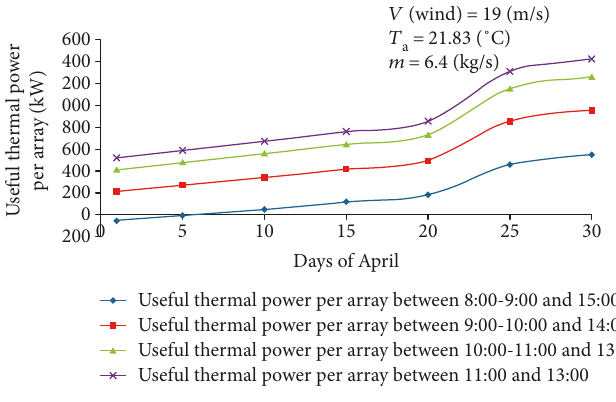
Figure 4: Useful thermal power per array for